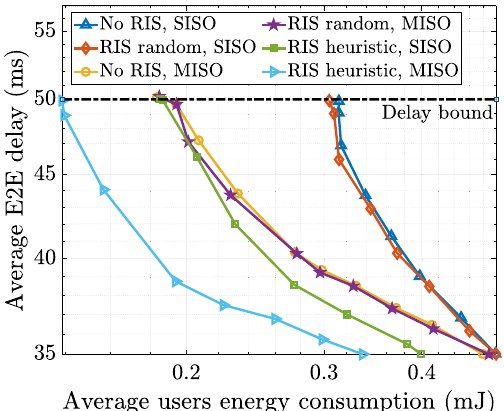
Fig. 3 Average delay vs. user energy for single- and multi-antenna